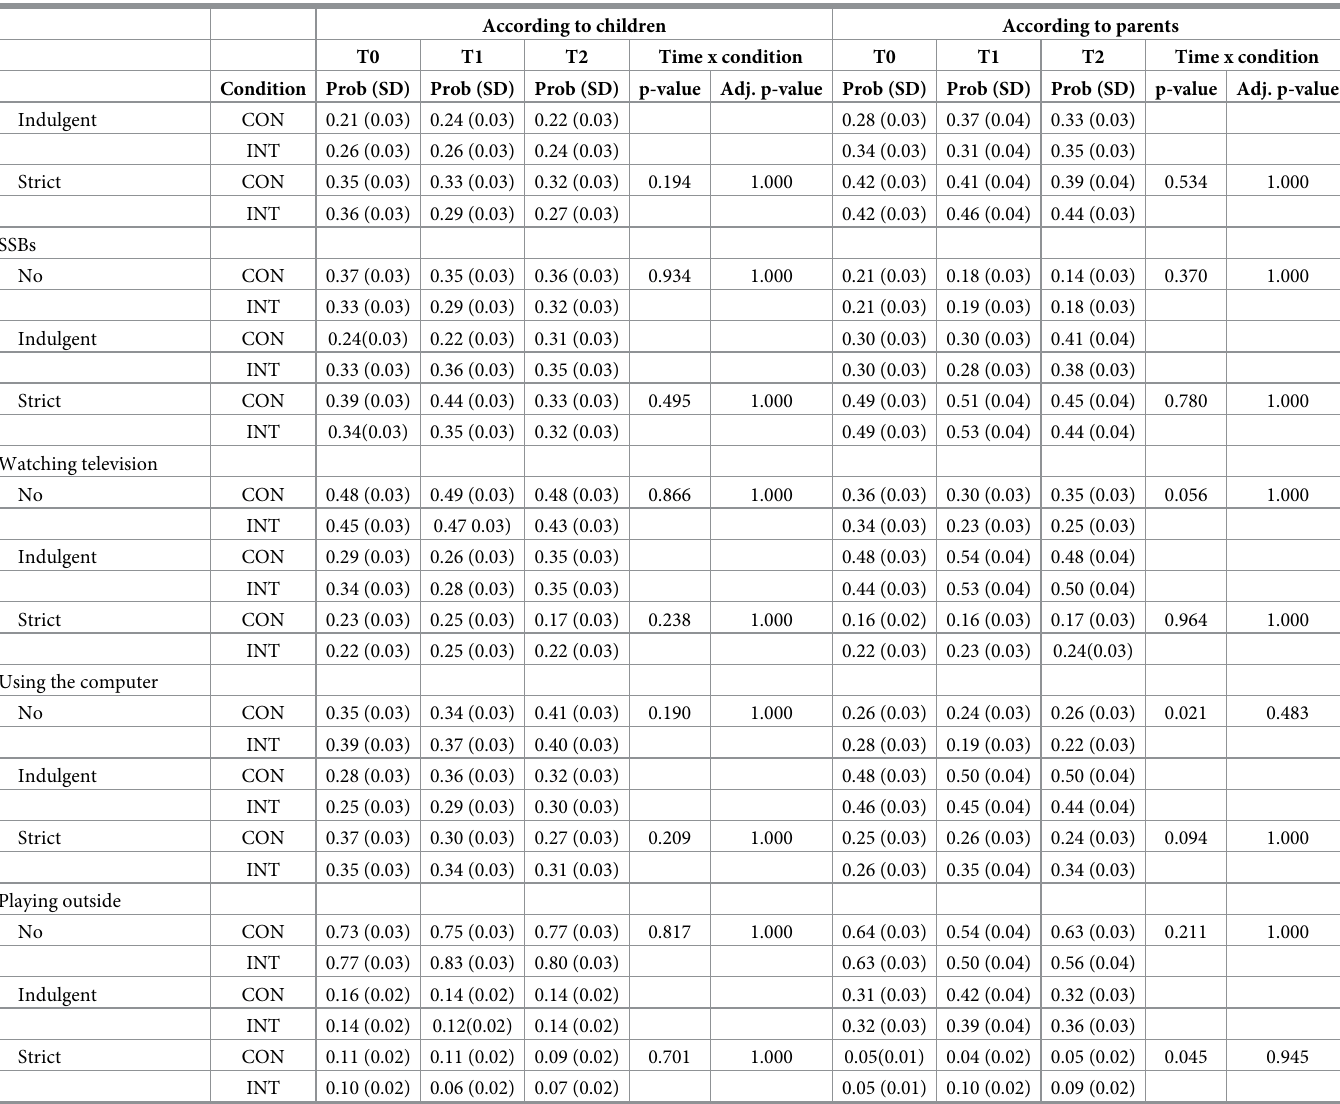
The multicategory variables for parental EBRB rules were dichotomized in order to compare between “no rules” and “indulgent/strict rules” and between “strict rules” and “no/indulgent rules”. Therefore 2 p-values for each parental EBRB rules are